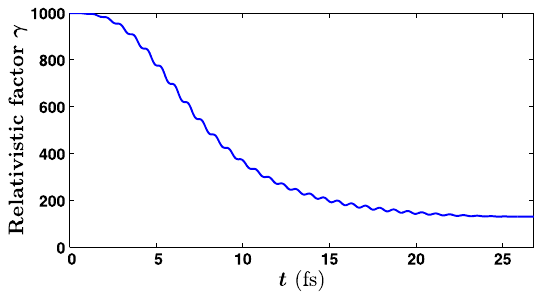
FIG. 4. Relativistic factor γ plotted vs time t for a sinusoidal- envelope linearly polarized laser pulse with angular frequency ω ¼ 2 × 10 15 s − 1 , maximum strength a width equal to 26.8 fs. The electron has an initial relativistic factor γ 0 ¼ 1000 .